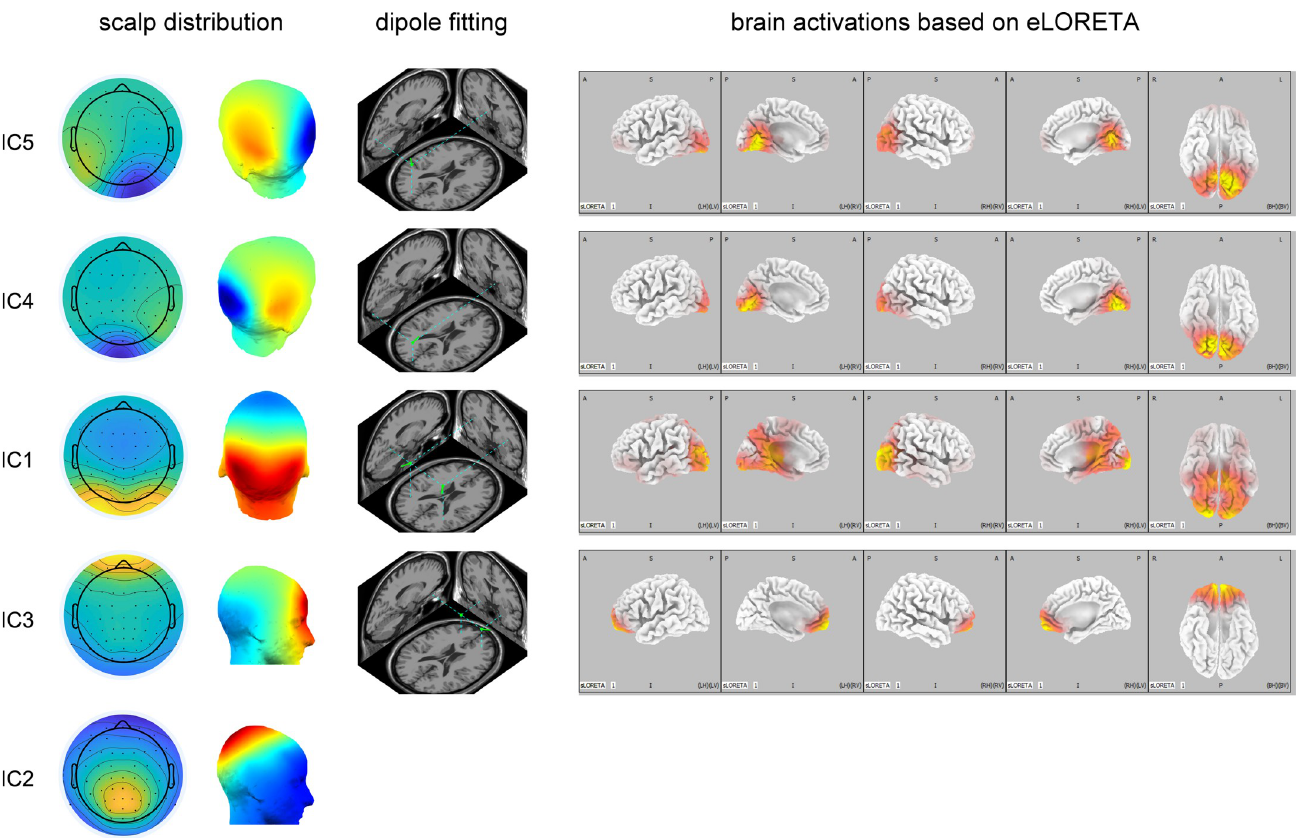
Fig 4. Source reconstruction results. The 2-D and 3-D topographies, the equivalent dipole(s) in an average brain, and the eLORETA results of each component are displayed. IC5 probably arose from the left primary/secondary visual cortices. IC4 probably arose from the right primary/secondary visual cortices. IC1 arose from a higher level of the visual cortex compared with IC5 and IC4, probably the bilateral associate visual cortices. IC3 probably arose from the orbitofrontal cortex (Brodmann area 11). IC2 clearly represented the P300 component.